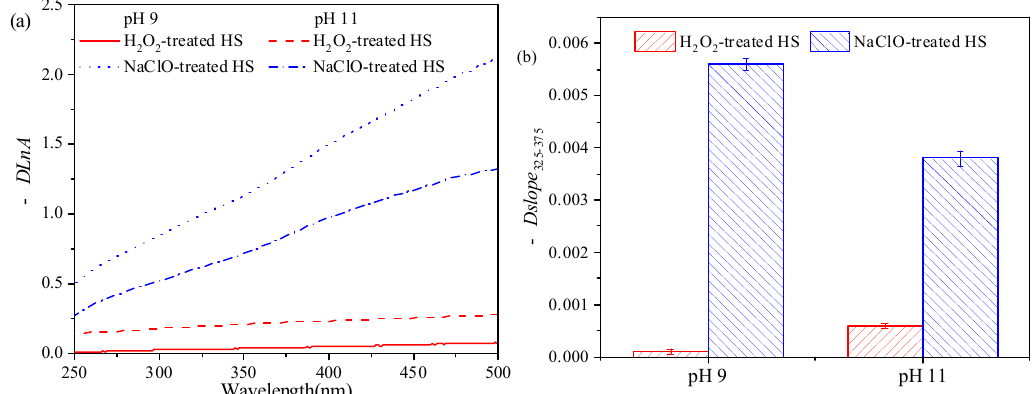
Figure 6. Differential log-transformed absorbance spectra ( − DLnA ) ( a ) and change in spectral parameter ( − DSlope 325–375 ) ( b ) of HS before and after reacting with H 2 O 2 and NaClO. The ratio of oxidant to DOC: 13:1; reaction time: 6 h.